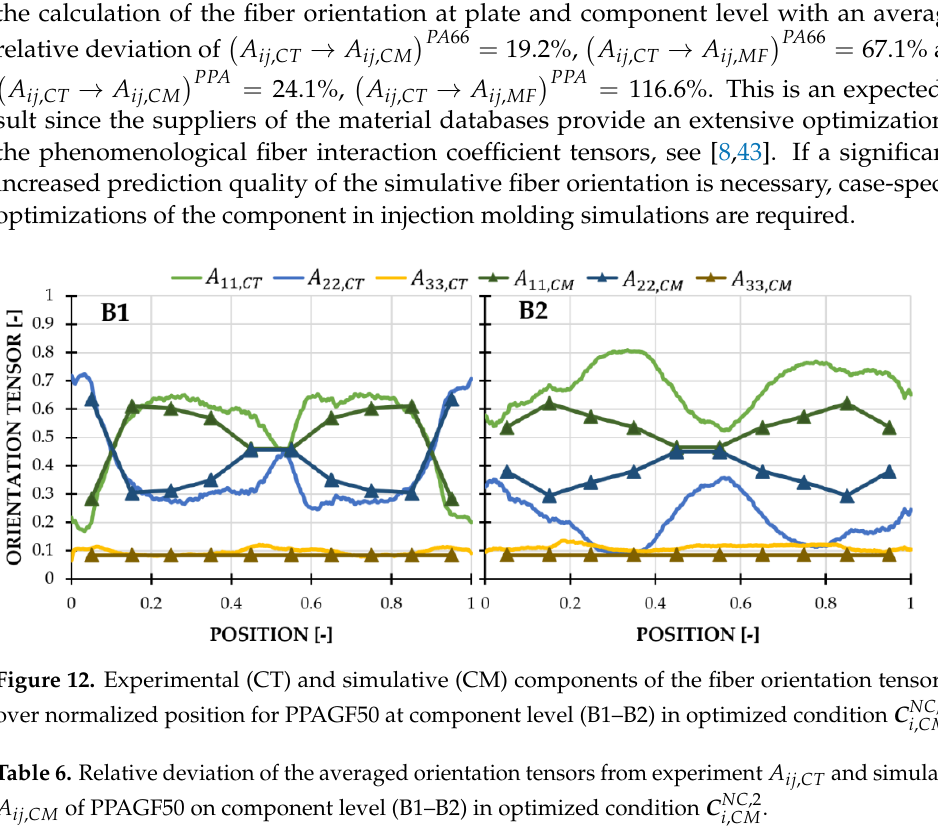
Table 6. Relative deviation of the averaged orientation tensors from experiment 𝐴 (cid:3036)(cid:3037),(cid:3004)(cid:3021) and simula- tion 𝐴 (cid:3036)(cid:3037),(cid:3004)(cid:3014) of PPAGF50 on component level (B1–B2) in optimized condition 𝑪 (cid:3036),(cid:3004)(cid:3014)(cid:3015)(cid:3004),(cid:2870) . Nr.